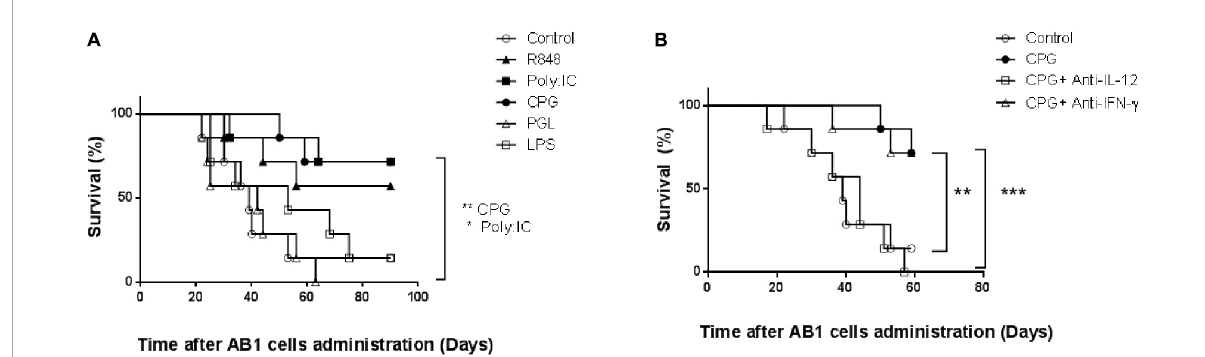
FIGURE4 Effect of toll-like receptor (TLR)9 ligation and interleukin-12 (IL-12) secretion on protection against early mesothelioma growth. (A) Survival of groups of BALB/c mice ( n = 8) either mock-treated (open circles) or treated with Poly (I:C) (closed squares), R848 (closed triangles), CpG-ODN (closed circles), lipopolysaccharide (LPS) (open squares) and peptidoglycan (open triangles) for two successive days before tumor administration. Groups were monitored daily after i.p. administration of mesothelioma AB1 cells. Experiment representative of three independent experiments. ** P = 0.0096 (CpG vs. control), * P = 0.02 [Poly (I:C) vs. control], respectively, by Log-rank (Mantel–Cox) test. (B) Survival of groups of BALB/c mice ( n = 7) either mocked treated (open circles) or treated for two successive days with CpG-ODN without (closed circles) or with anti-IFN- γ (open triangles) or anti-IL-12 (open squares) treatment, was monitored daily after i.p. administration of AB1 cells. Experiment representative of two independent experiments. *** P = 0.0008 (CpG vs. CpG+anti-IL-12), ** P = 0.0096 (CpG vs. control), and P = 0.023 (CpG+anti-IFN- γ vs. control), respectively by Log-rank (Mantel–Cox)